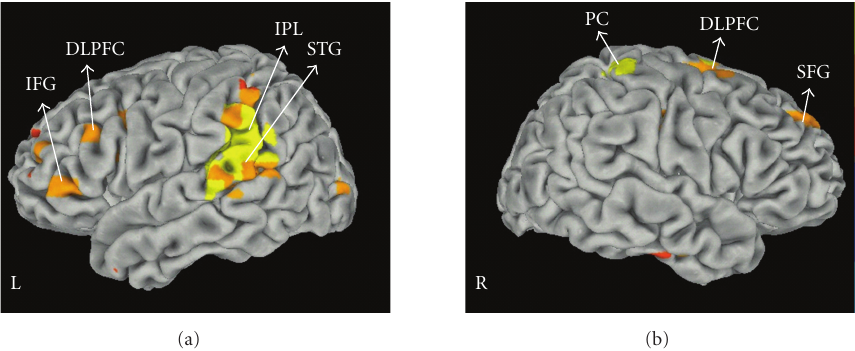
Figure 4: Group maps corresponding to 200 ms interval (from − 1700 ms to − 1500 ms) preceding the trials onset at beta frequency (14– 30Hz); P < . 01 corrected; DLPFC: dorsolateral prefrontal cortex; IFG: Inferior frontal gyrus; IPL: inferior parietal lobe; PC: postcentral gyrus; SFG: superior frontal gyrus. Red color coding indicates task related power increase; blue color coding indicates task related power decrease. The figure shows data rendered onto a Talairach-space surface template.